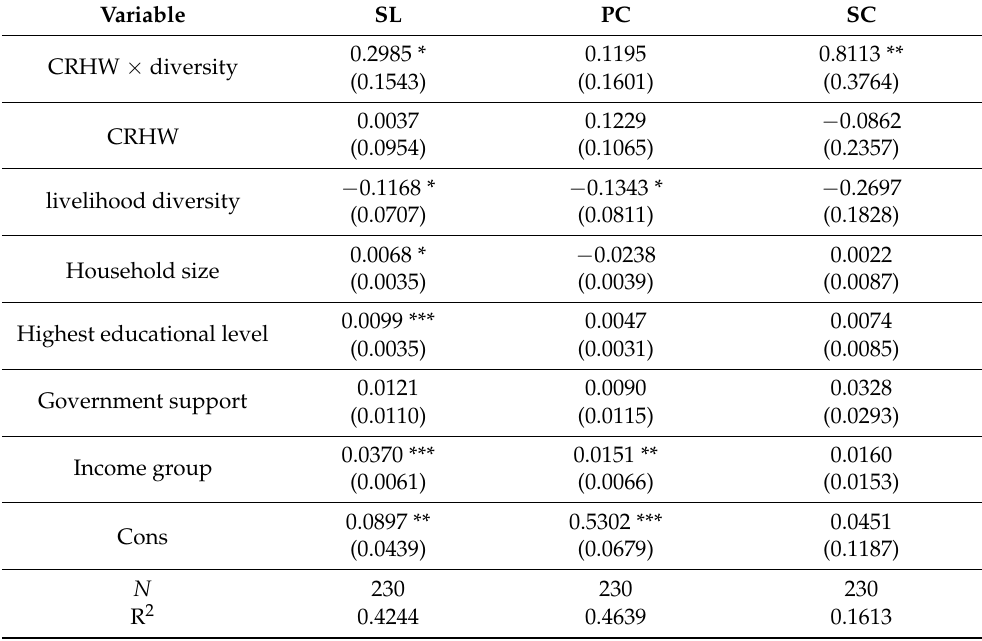
Table 7. Moderation analysis of livelihood diversity between the CRHW, sustainable livelihoods, and livelihood